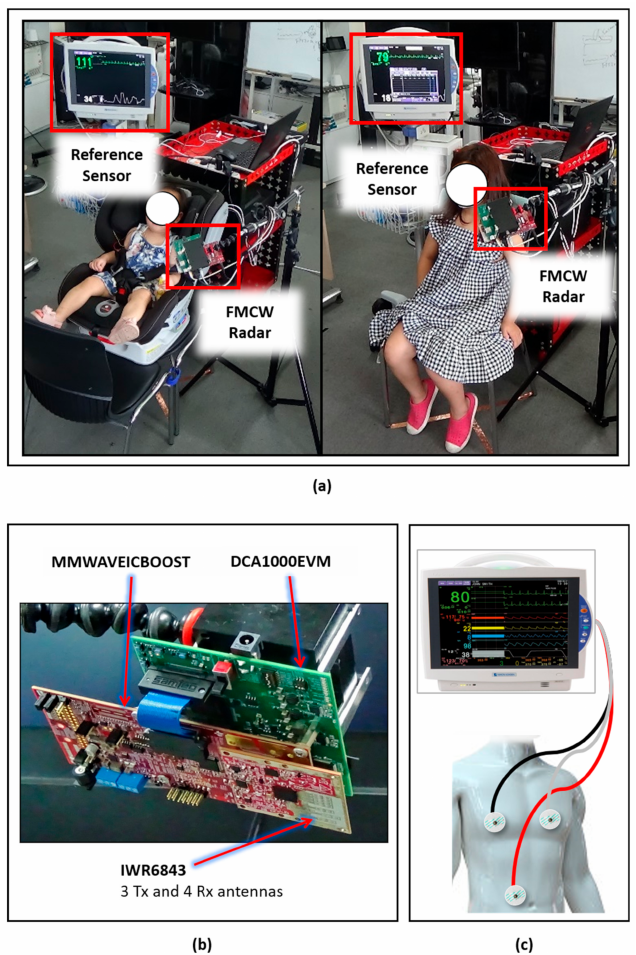
Figure 1. Data acquisition setup: ( a ) Data collection environment. Left: Child younger than 6 years of age sitting in a car seat. Right: Child greater than 6 years of age sitting in a normal seat. ( b ) Frequency-modulated continuous-wave (FMCW) radar system for data acquisition. ( c ) Setup and connectivity details for the clinical reference